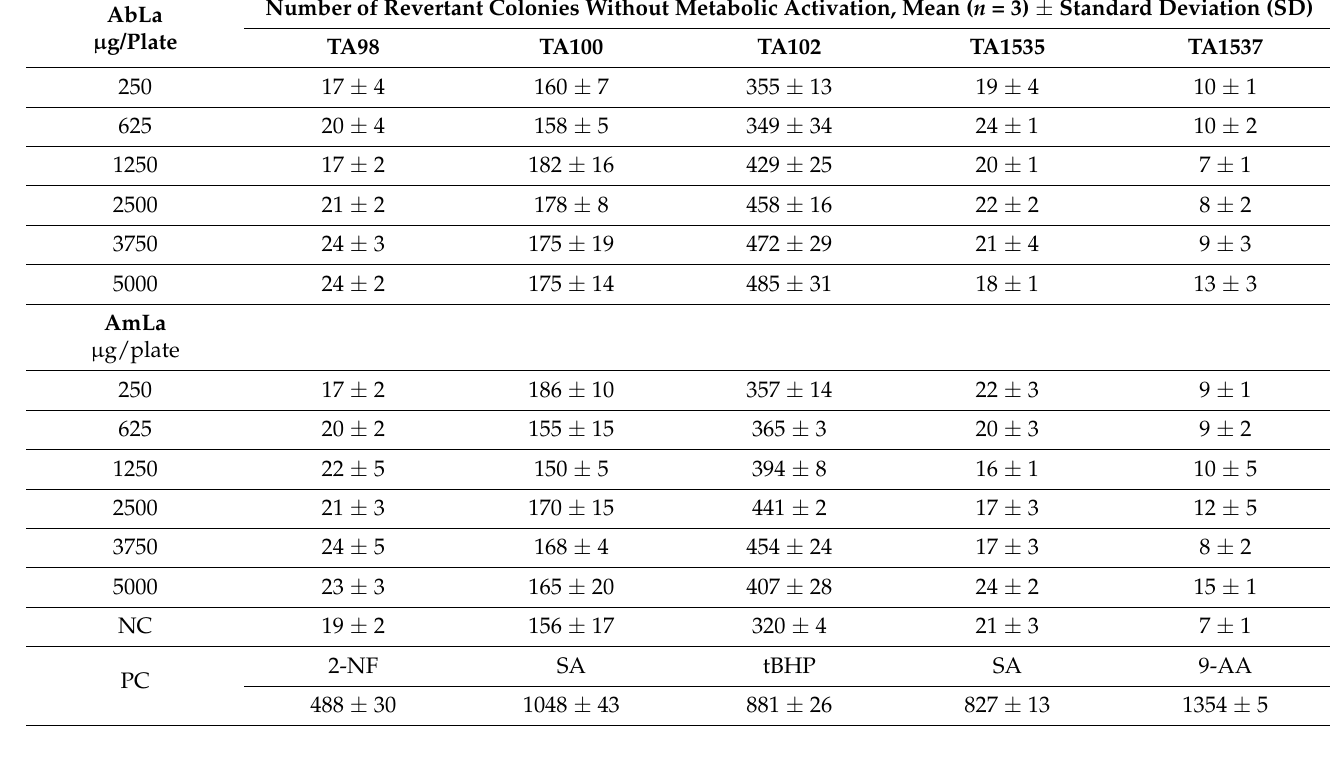
Table 5. Mutagenicity of A. bento-rainhae and A. macrocarpus leaf crude extracts in the bacterial reverse mutation test (Ames